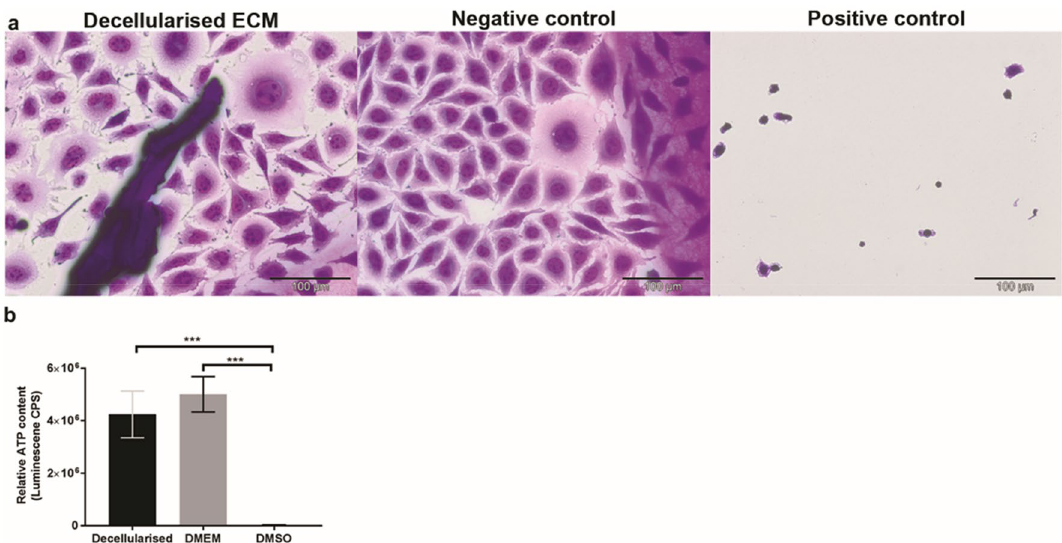
Figure 5. Cytotoxicity analysis of decellularised rat pulp tissue. ( a ) Microscopic analysis of contact cytotoxicity assay cultured with L-929 cells and stained with Giemsa stain. Decellularised tissues resulted in no obvious cytotoxicity with cell growth in contact with the pulp tissue. Collagen gel (negative control) resulted in no cytotoxicity. Cyanoacrylate glue (positive control) resulted in marked cytotoxicity. ( b ) Bar graph results of extract cytotoxicity assay measuring the relative cellular ATP content of L-929 cells. Y-axis relative cellular ATP measurements. Data represent mean values ( n = 8) ± 95% confidence intervals. Data analysis revealed no significant difference between decellularised extracts and DMEM (negative control) and statistical significance in comparison with DMSO (positive control) (ANOVA, **** p < 0.0001). ATP adenosine-5-triphosphate, DMEM Dulbecco’s modified Eagle’s medium, DMSO dimethyl sulfoxide, ECM extracellular matrix. Scale bars are at 100